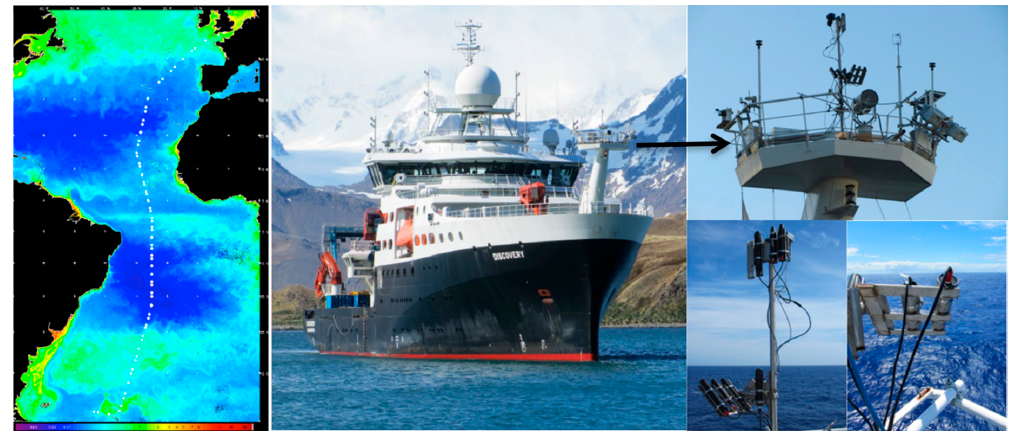
Figure 15. The route of AMT-27 through the Atlantic and the position of the FRM4SOC radiometers on RRS Discovery in operation during AMT-27.